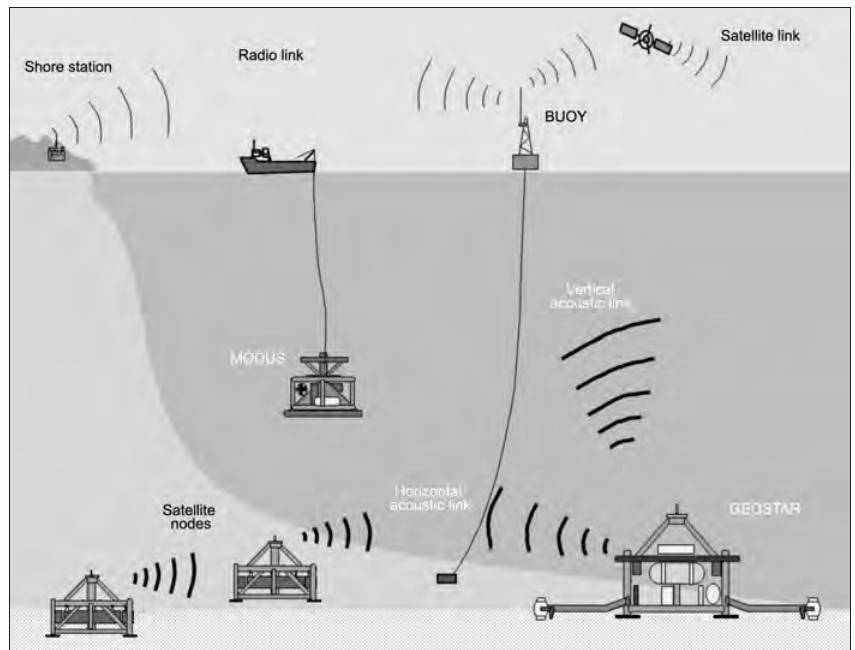
Fig. 9. Scheme of management and operation of the ORION-GEOSTAR-3 deep-sea network of GEOSTAR- class seafloor observatories.